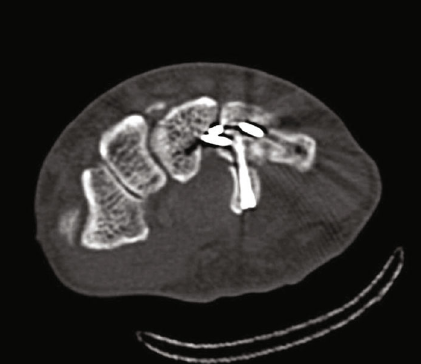
Figure 6: Postoperative CT scan showing the reduction and appropriate placement of the